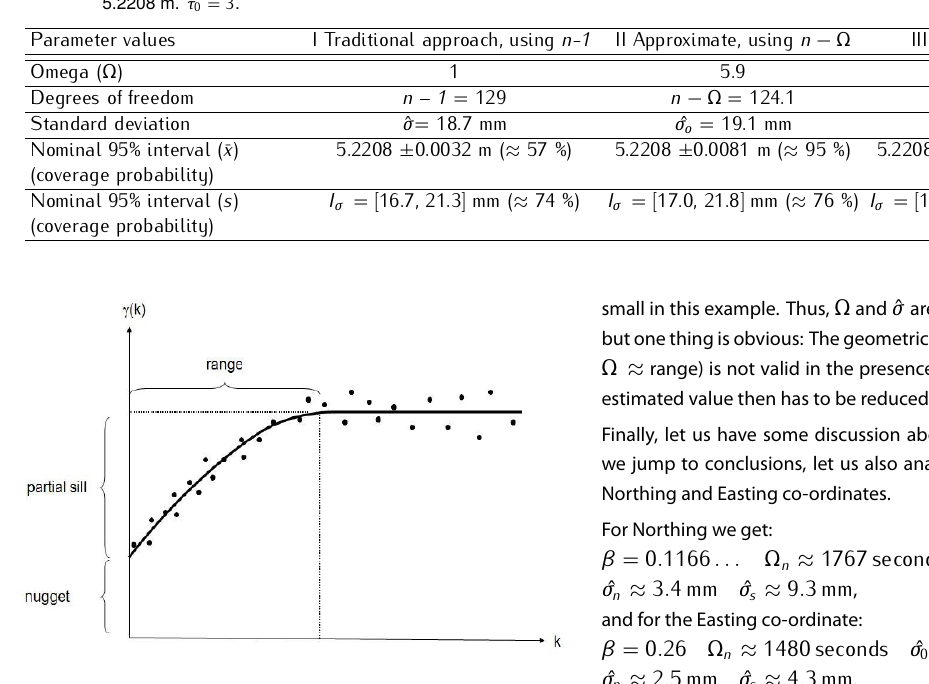
Table 3. A study of different methods for the construction of confidence intervals for the mean and standard deviation, using real GPS observations (the same methods as in Table 2, and the same data as in Figure 6). The number of observations is n = 130 , and the mean value is ¯ x = 5.2208 m. ˆ τ 0 = 3 .